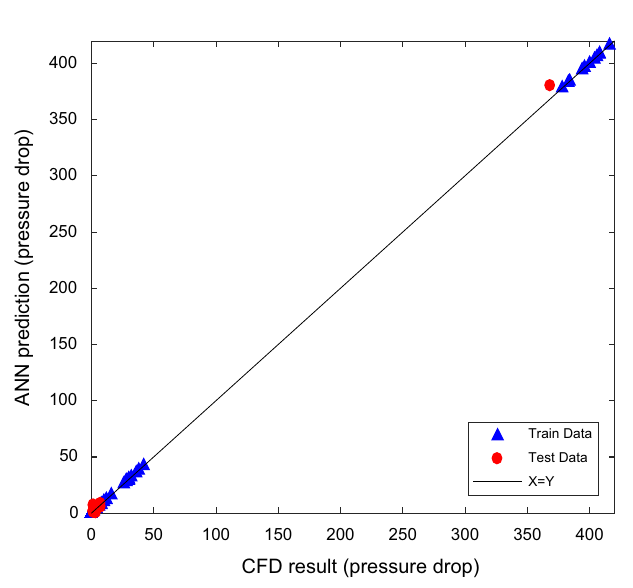
Figure 4. Validation of predicted versus calculated gas pressure drop for train and test